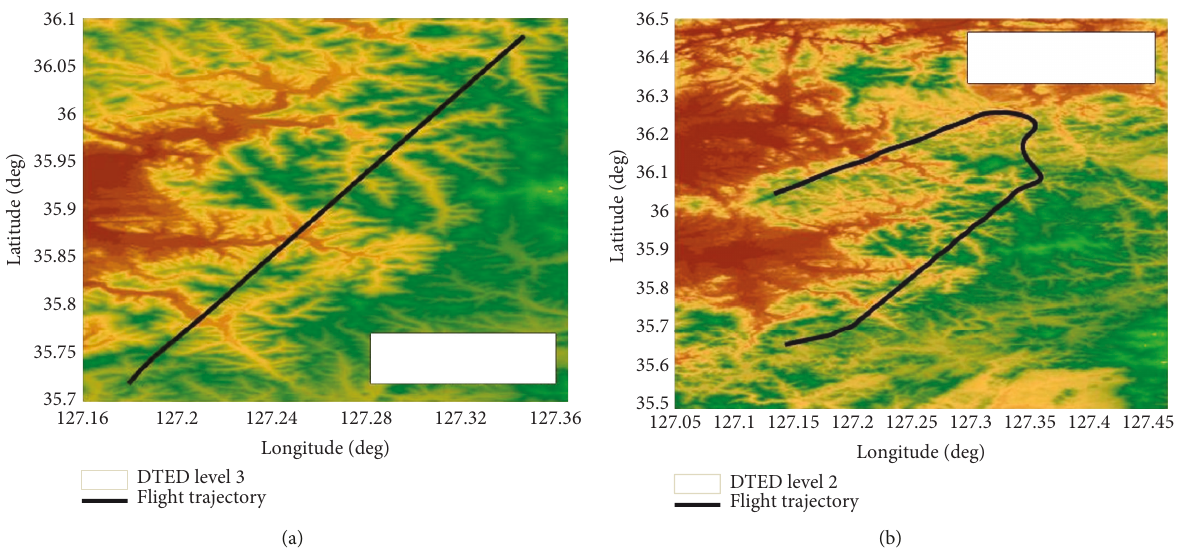
Figure 3: DEM fi tting areas and fl ight trajectories. (a) DEM level 3 fi tting area. (b) DEM level 2 fi tting area.